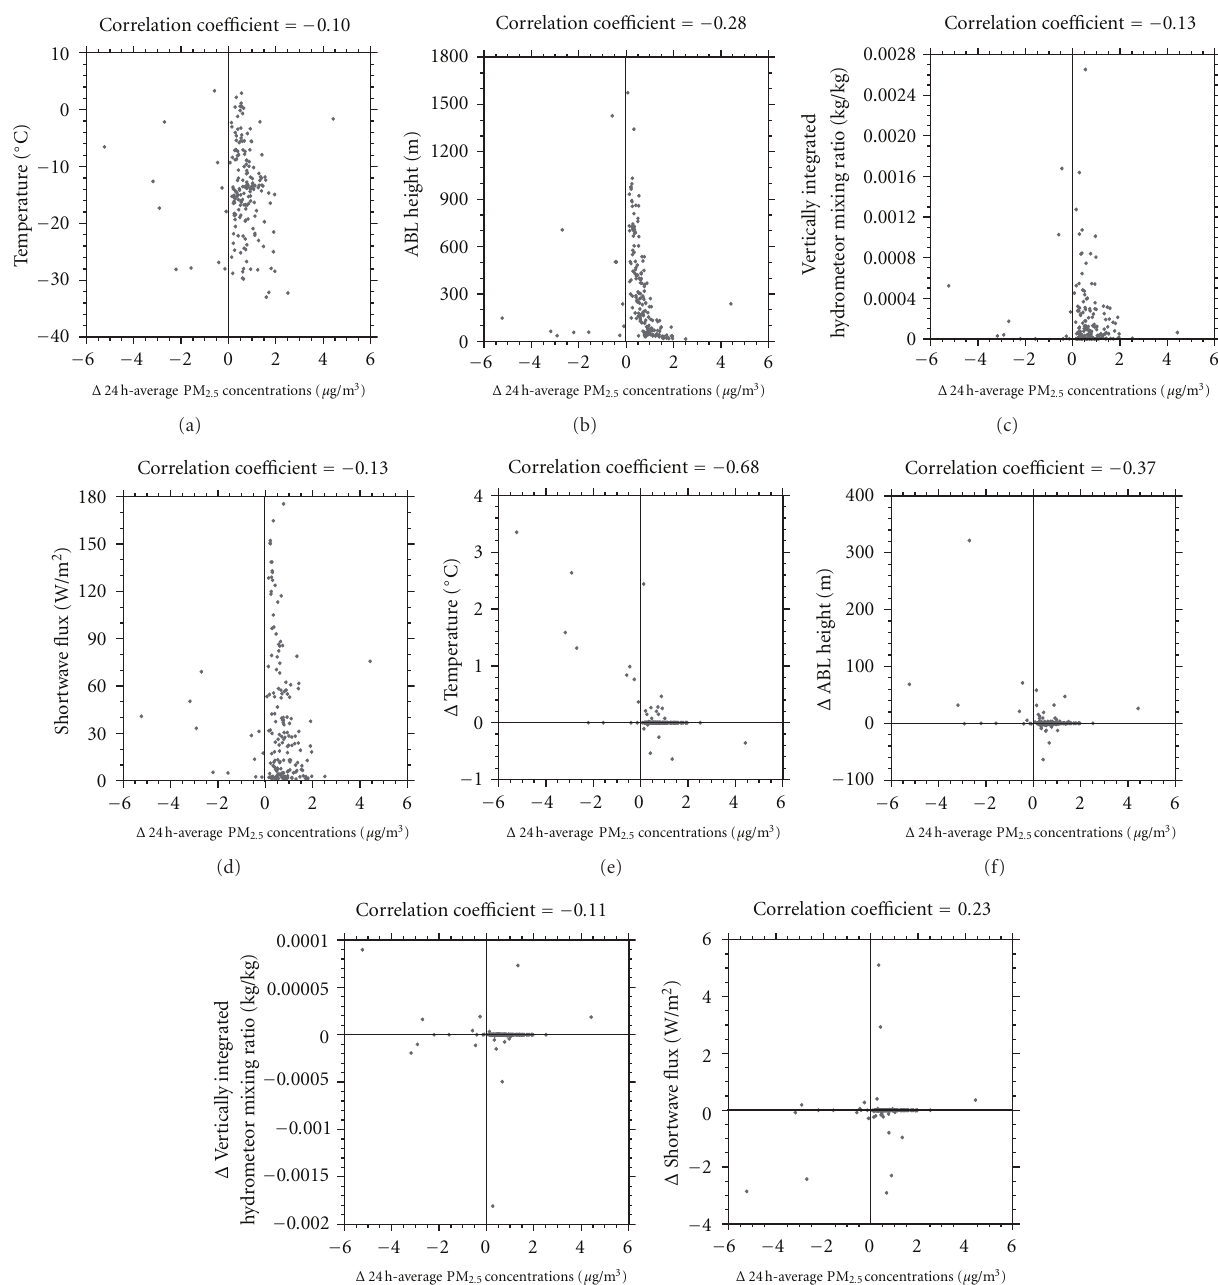
Figure 5: Scatter plots of the REF simulation of 24h-average PM 2 . 5 concentrations versus (a) near-surface temperature, (b) ABL height, (c) vertically integrated hydrometeor mixing ratio, and (d) downward shortwave radiation, and di ff erences REF-LSF of 24 h-average PM 2 . 5 concentrations versus di ff erence (REF-LSF) of daily mean (e) near-surface temperature, (f) ABL height, (g) vertically integrated hydrometeor mixing ratio, and (h) downward shortwave radiation in the nonattainment area for the 182 simulation days. The lines crossing at zero indicate nondi ff erences with respect to the values at the x and y